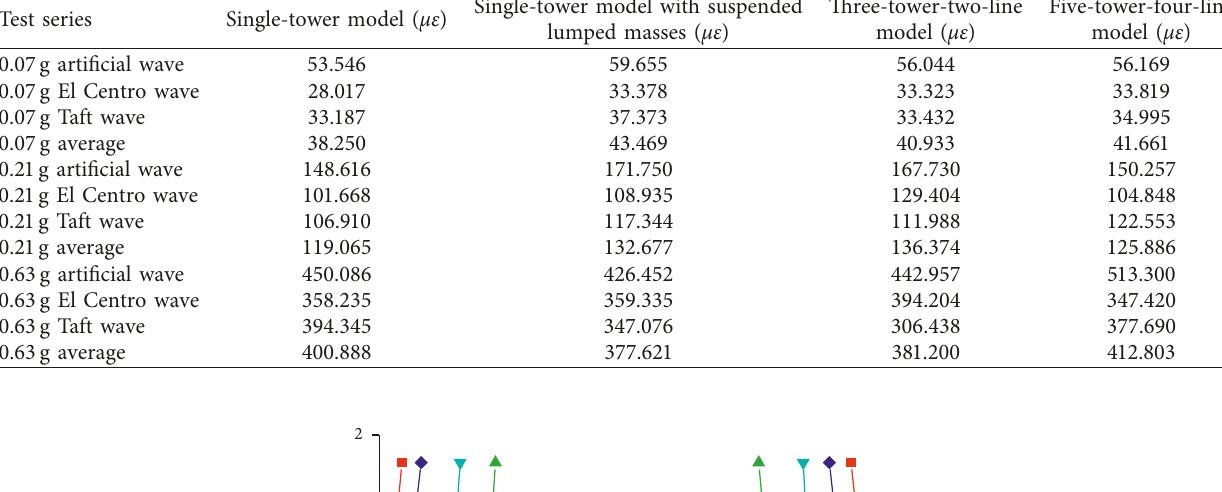
Table 9: Longitudinal peak strain responses of the middle towers of the four models.